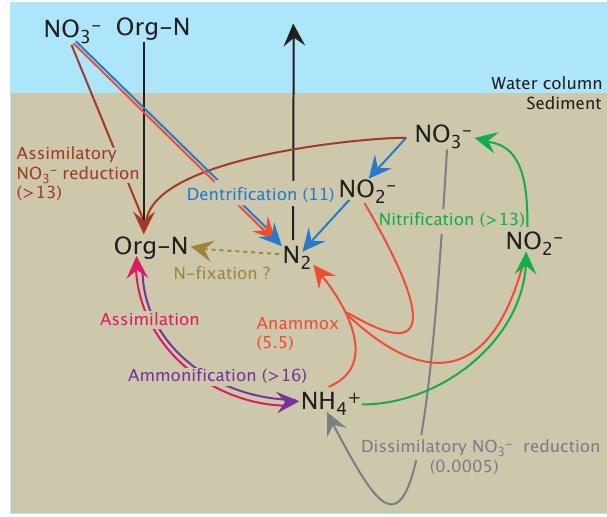
Fig. 1. Schematic illustration of the sedimentary N-cycle in the Lower St. Lawrence Estuary (LSLE). Numbers in parentheses are the rates in µmolm − 2 h − 1